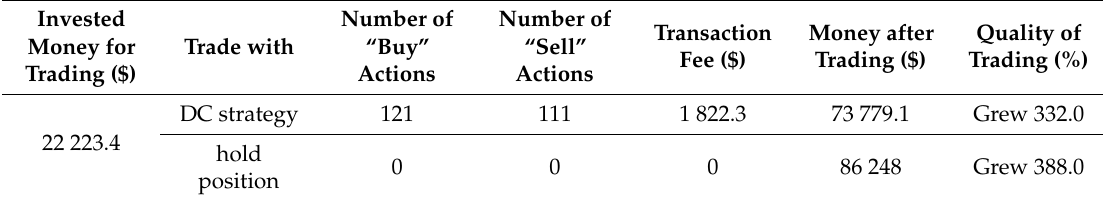
Table 1. Main information about the trading process.